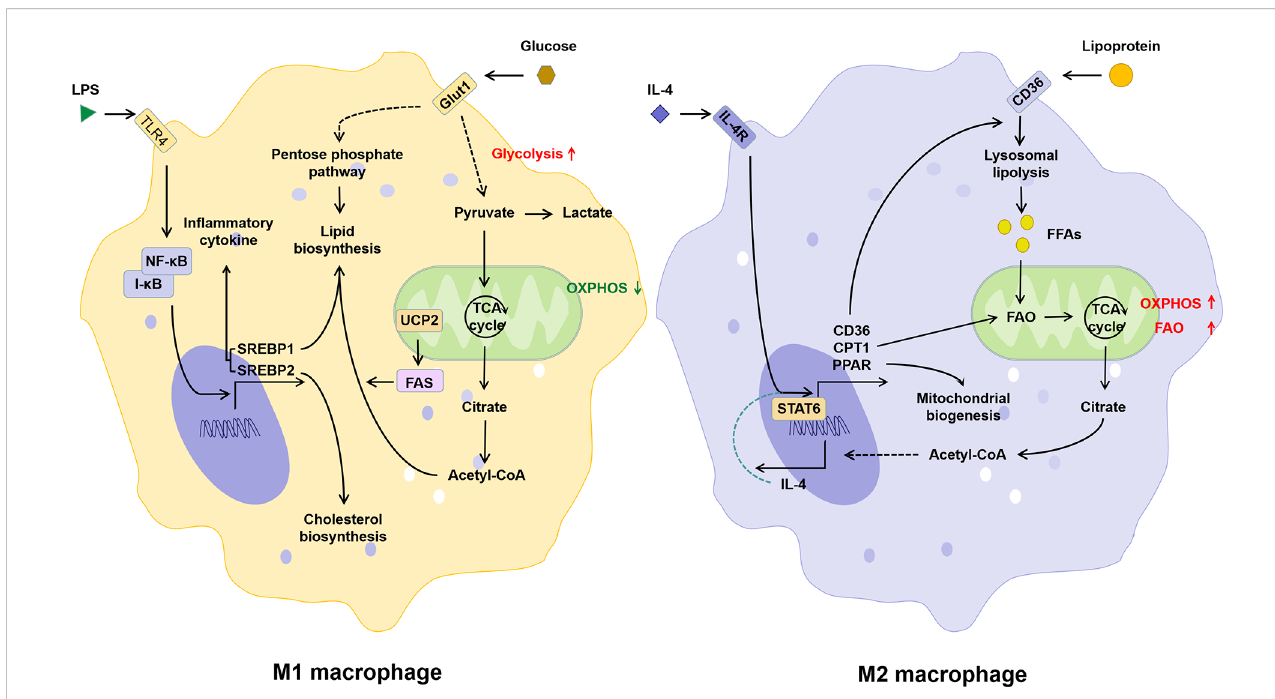
FIGURE 3 The relationship between lipid metabolism and phenotype of macrophages. Activation of the TLR signaling pathway induced by LPS promotes M1 polarization of macrophages, which is manifested by increased glucose uptake, glycolysis, lipid biosynthesis and decreased OXPHOS. The IL-4 induced M2 polarization of macrophages is manifested as the increase in lipid intake, FAO, and OXPHOS. IL-4, interleukin-4; IL-4R, interleukin-4 receptor; I- k B, inhibitor of NF- k B; LPS, lipopolysaccharide; NF- k B, nuclear factor kappa-light-chain-enhancer of activated B cells; PPAR, peroxisome proliferative activated receptor; SREBP, sterol-regulatory element binding protein; STAT6, signal transducer and activator of transcription 6; TLR4, toll-like receptor 4; UCP2, uncoupling protein